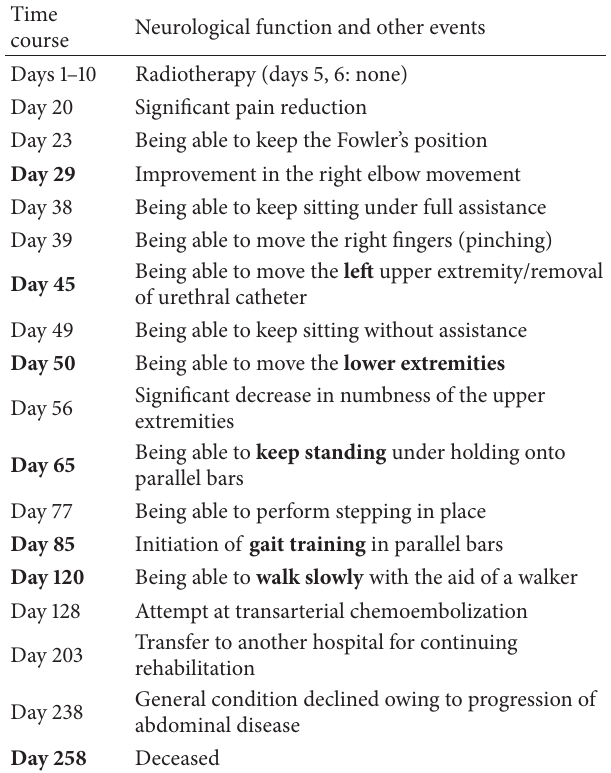
Table 2: Clinical course after the commencement of